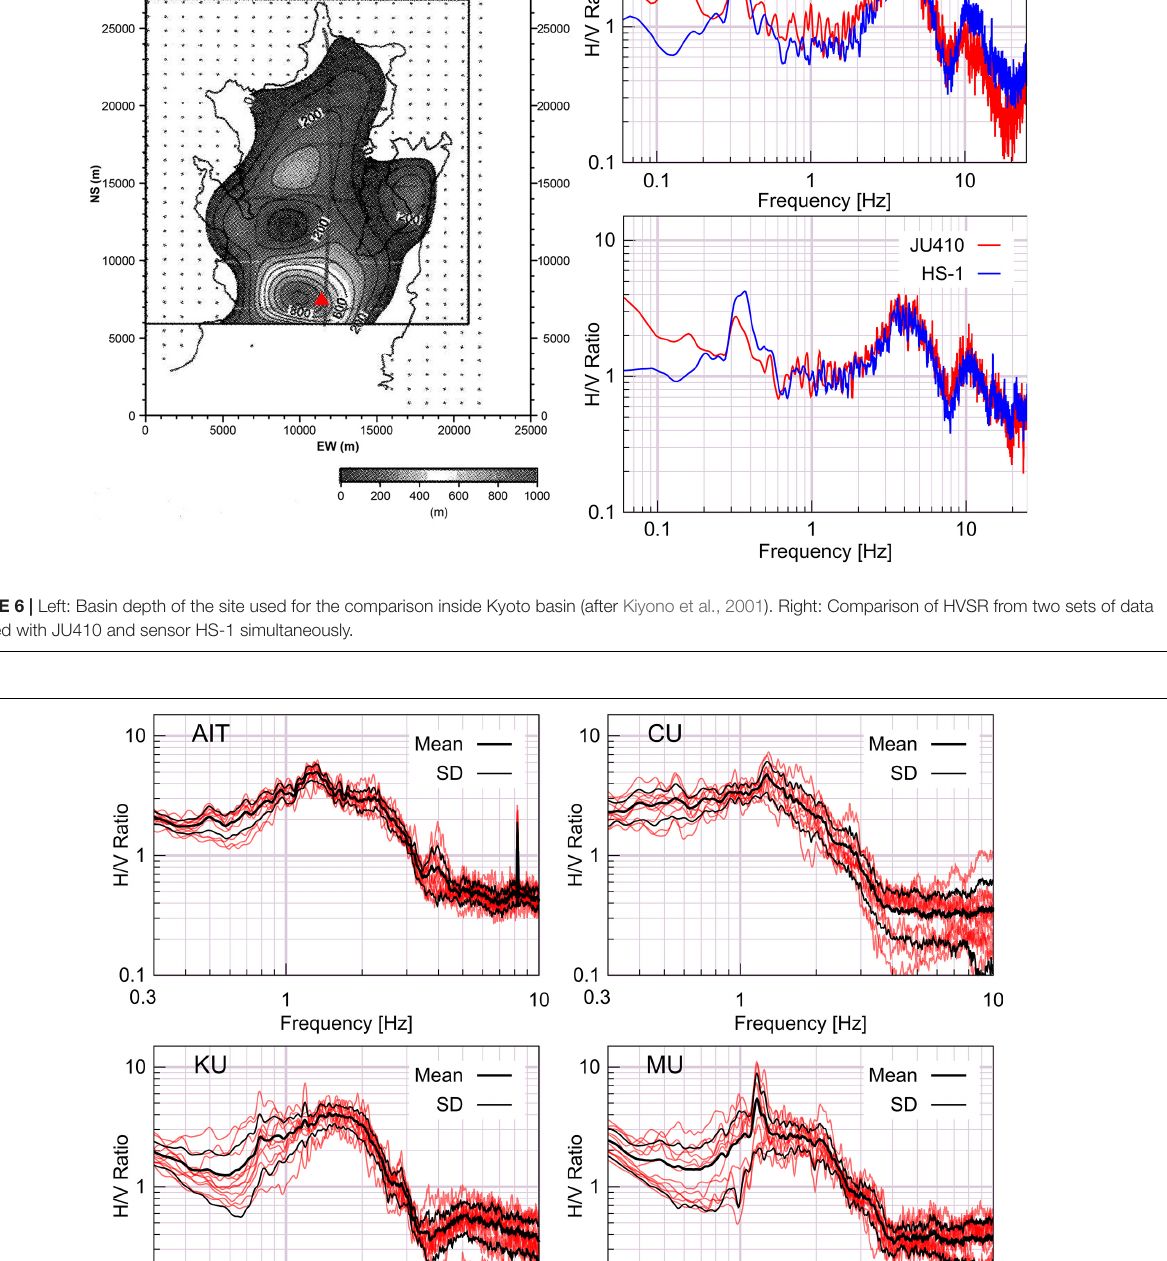
Frontiers in Built Environment |